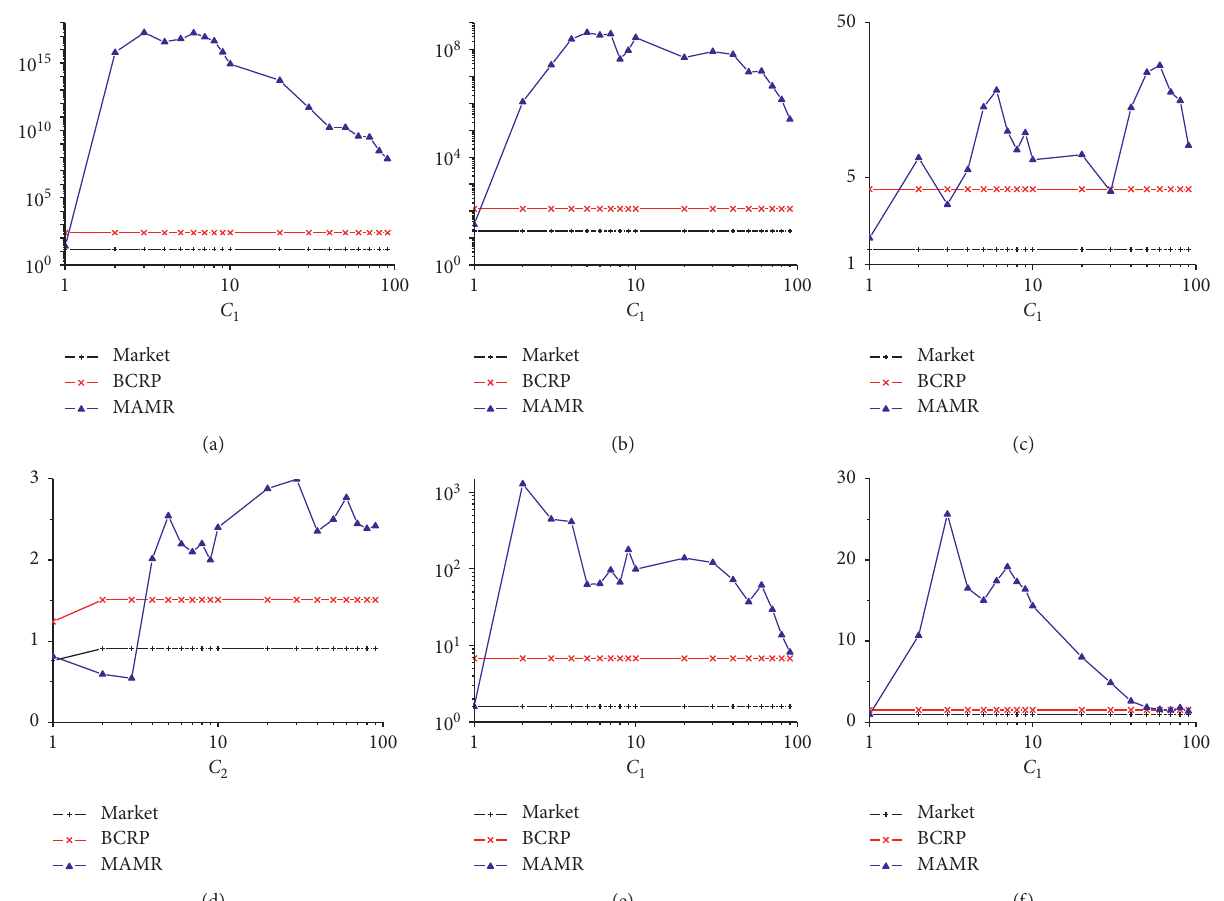
Figure 4: Parameter sensitivity of MAMR with respect to C (d) DJIA. (e) TSE. (f) MSCI.